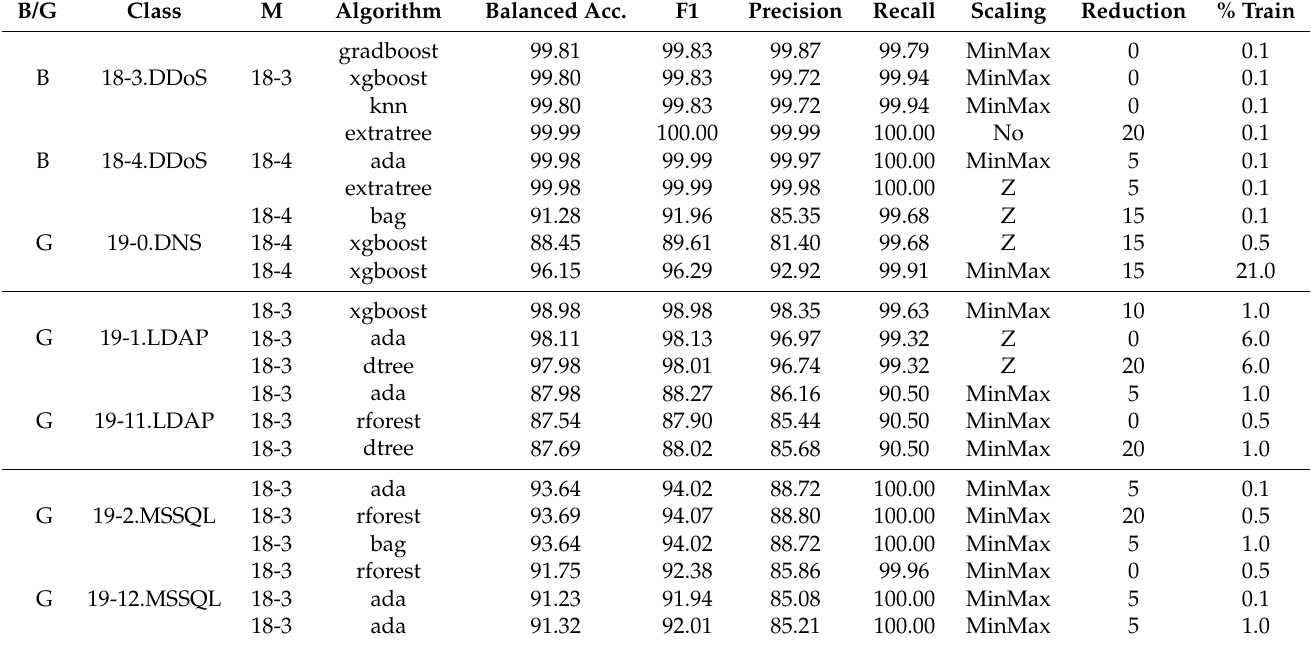
Table 9. Classification metrics for the best 3 models per attack class, both for baseline (B) and generalized (G) classification, with mention of the preprocessing